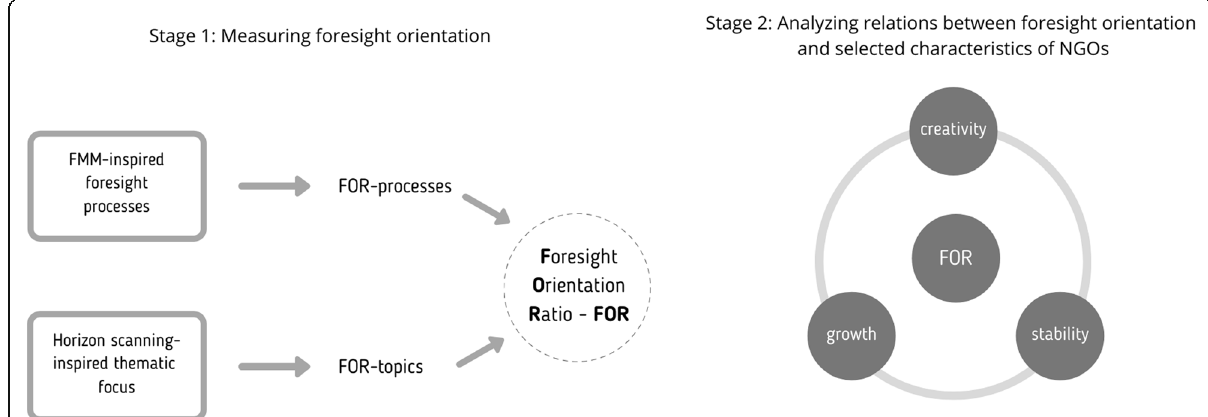
Fig. 1 Stages of the methodology applied in the